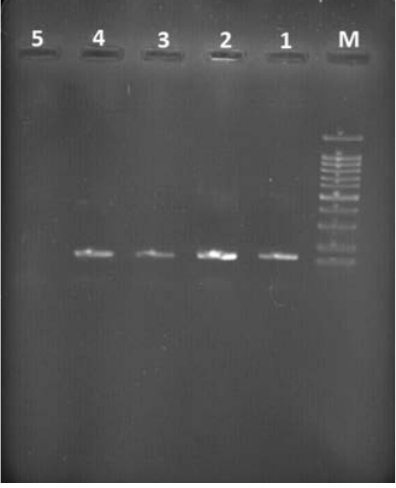
Figure 1. Results of the gel electrophoresis for the 16SrRNA gene of the H. pylori strains detected in fecal samples of healthy and complicated dogs. M: 100 bp ladder, 1: Positive control, 2-4: Positive sample for the 16SrRNA gene (110 bp), and 5: Negative